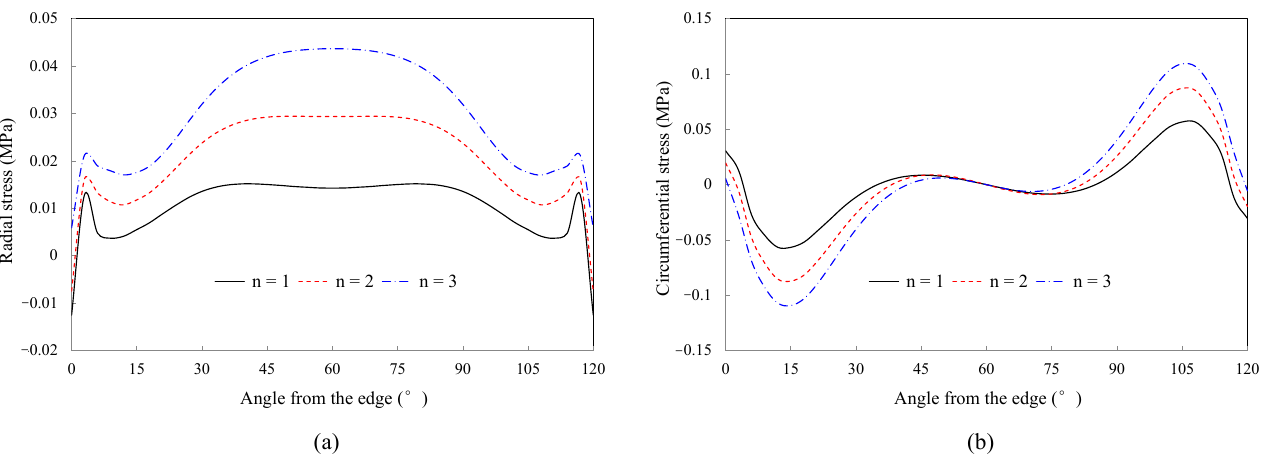
Figure 10. Effect of n on the reinforced interface stresses: ( a ) radial stress; ( b ) circumferential stress.